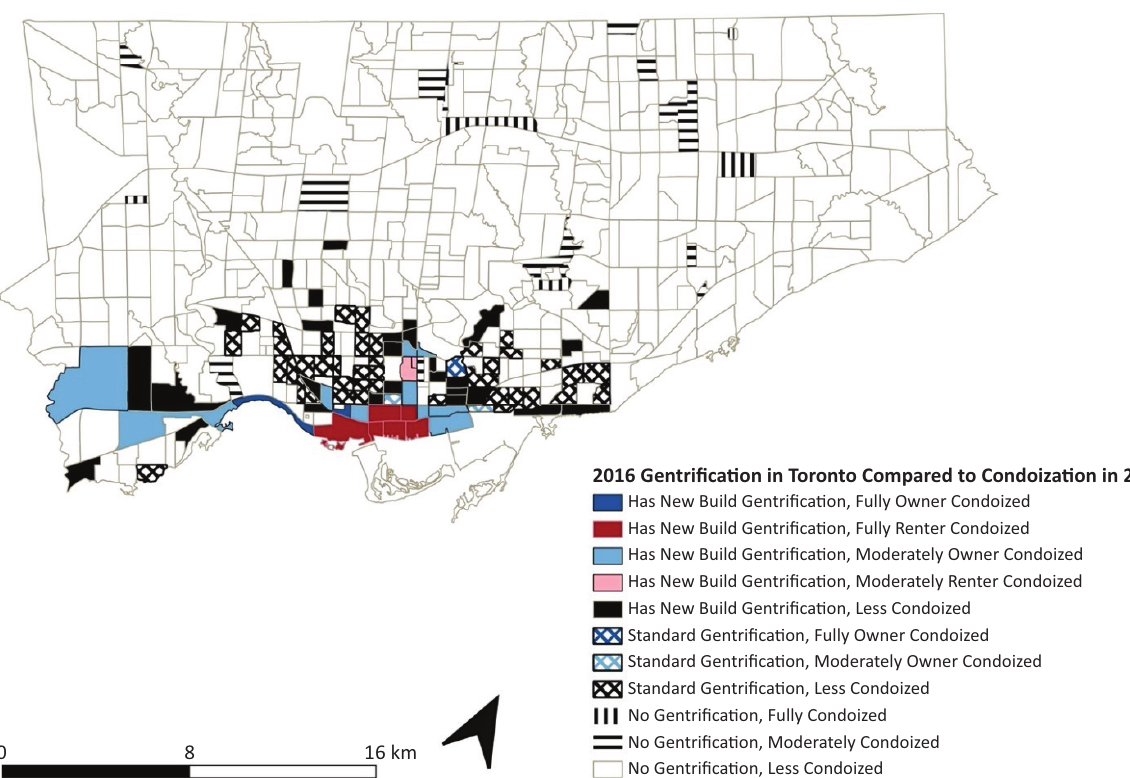
Figure 8. Condoization and gentrification typologies in Toronto. Notes: Tracts are indexed along three metrics—(a) the degree of condoization, whether the housing stock is fully ( > 75%), moderately (50–75%), or less condoized ( < 50%); (b) the predominant tenure of condos in condoized tracts, whether renter or owner; and (c) the primary type of gentrification in the tract (these were simplified to “has new build” for those tracts with new build gentrification as at least one type and standard gentrification/conversion for tracts with no new build gentrification). Source: Calculated by the authors using custom tabulated census tract level data provided by CMHC (2020a) and Statistics Canada (1971, 2001,